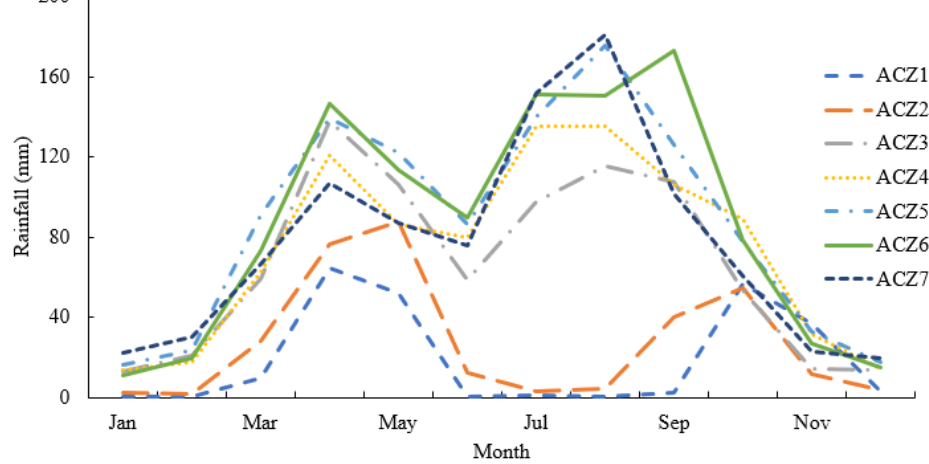
Figure 4. Rainfall monthly distribution in WSRB agroclimatic zones.